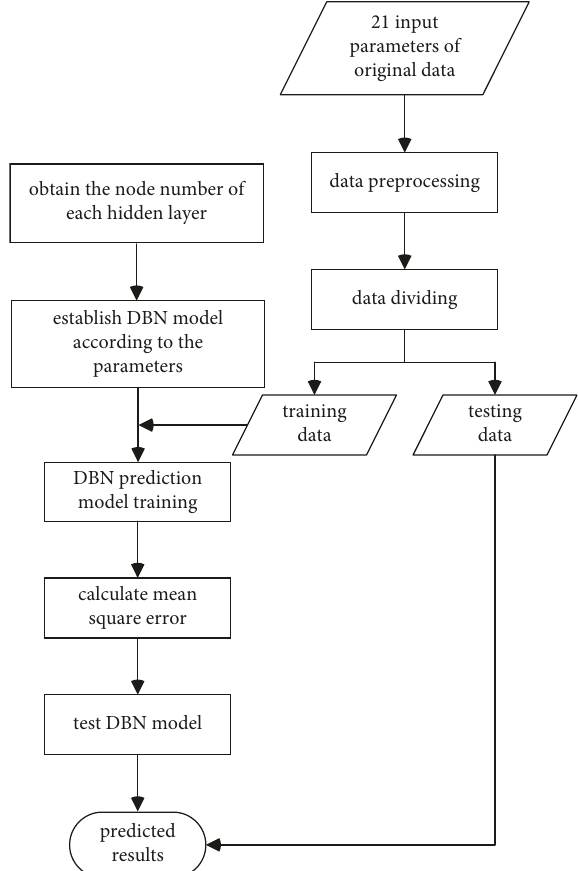
Figure 2: The algorithm